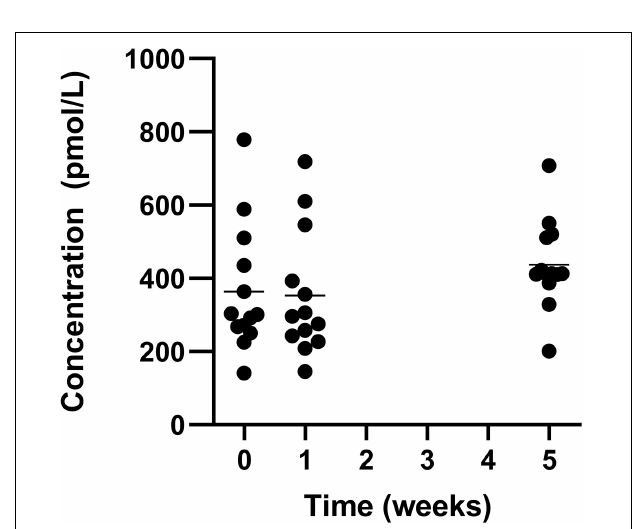
FIGURE 6 | Circulating vitamin D for the 19 participants who completed the study. The mean of each measurement shown as a solid black line.